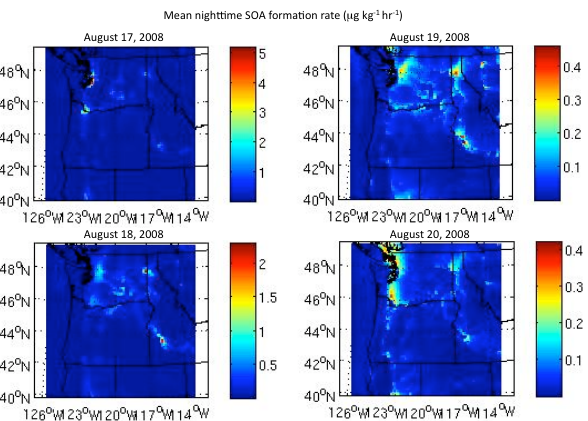
Fig. 8. Zoom-in on the Pacific Northwest to demonstrate spatial and temporal variability of NO 3 -initiated SOA source in this lower-NO 3 -concentration region.